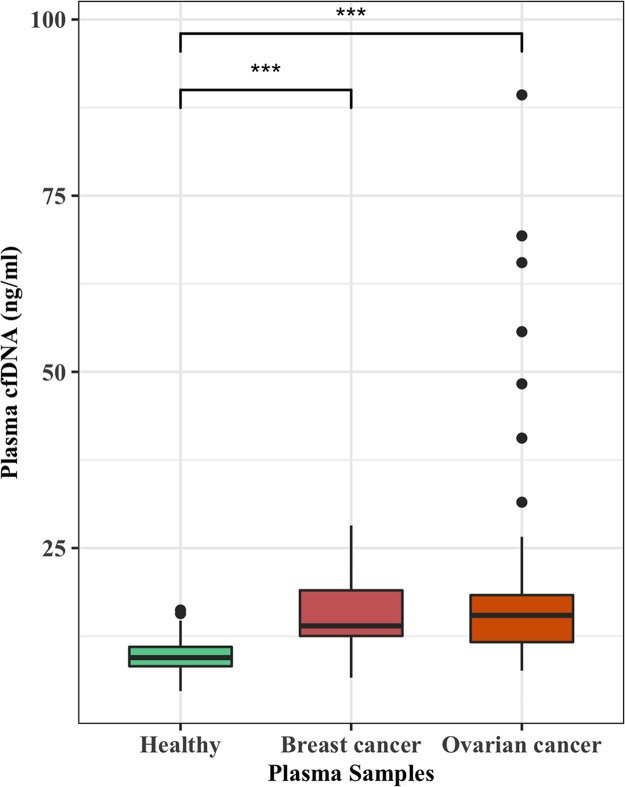
Plasma cfDNA levels are significantly elevated in cancer patients.Plasma cell-free DNA (cfDNA) was isolated from breast (n = 26) and ovarian cancer (n = 64) patients with various stages and undergoing treatment. Female subjects (n = 50) from healthy individuals of a similar age were selected as controls for breast and ovarian cancer patients. Separate cfDNA comparisons wre made between healthy female controls and the cancers patients by Wilcoxon rank sum test. Highly significant differences (***) were observed between cfDNA levels measured by Qubit fluorometer (ng/ml) of healthy females and breast cancer patients (p = 6.278e-07) and healthy females and ovarian cancer patients (p = 2.708e-11).